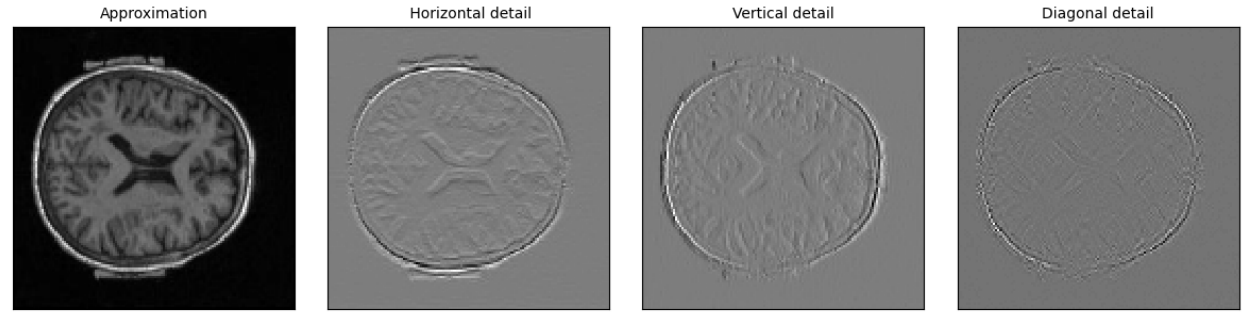
Figure 2. Wavelet transform of the sample EMCI participant MRI